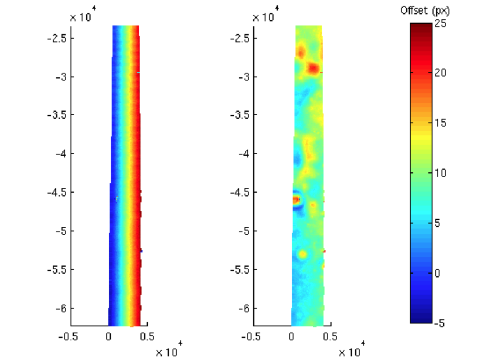
Figure 3. Down-track (left) and cross-track (right) offsets between a NAC-L and NAC-R with roughly the same footprint, plotted against line and sample, before twist correction. Y-axis units are 10 4